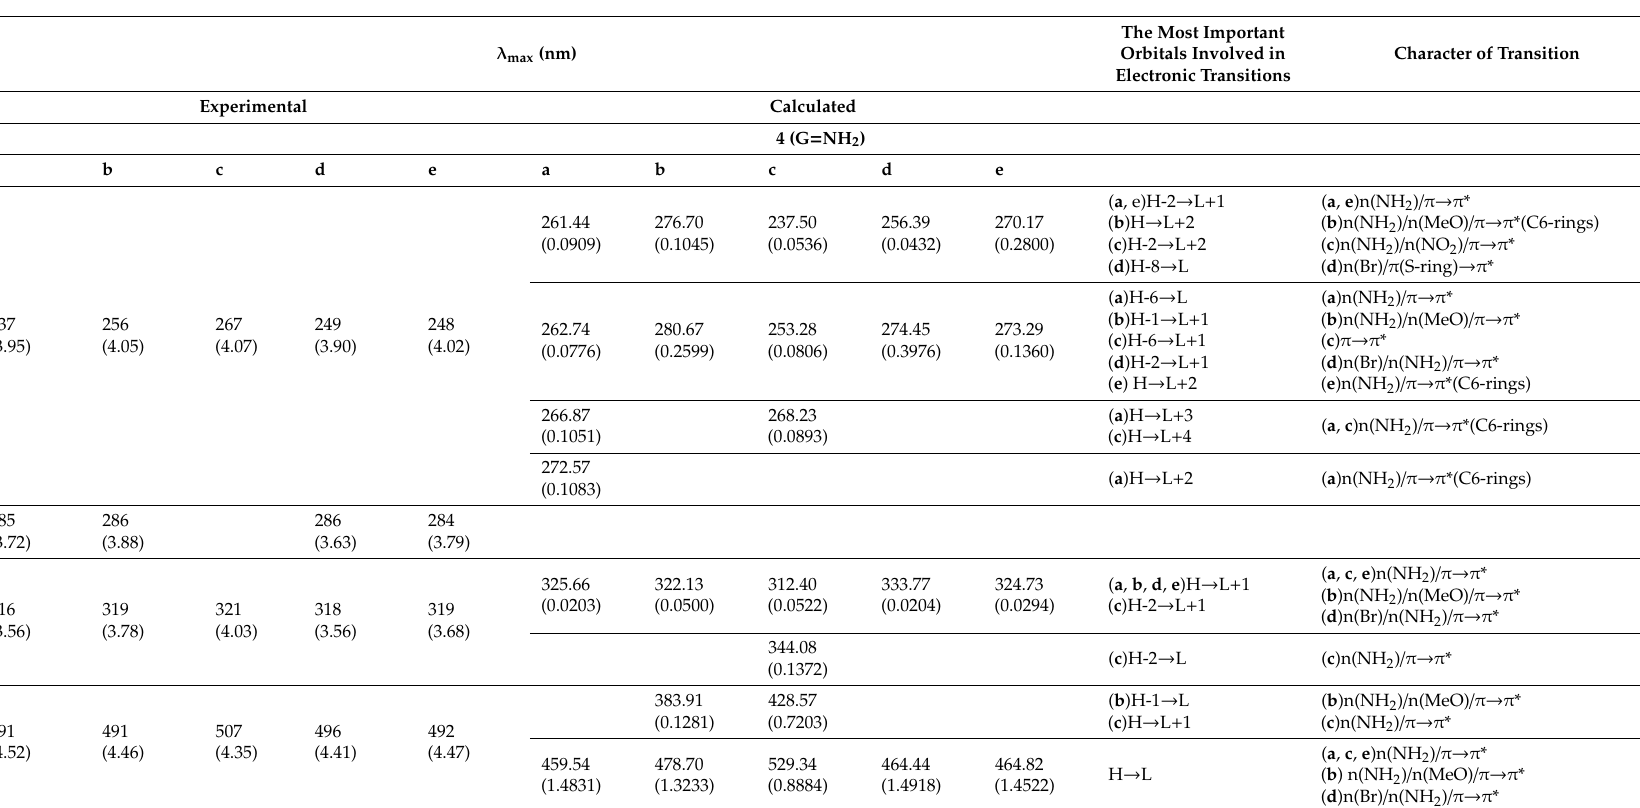
Table 1. Most important electronic transitions. H letter indicates Highest Occupied Molecular Orbital HOMO, L indicates Lowest Unoccupied Molecular Orbital LUMO and +/ − (number) represent subsequent orbitals above HOMO and LUMO, respectively. The logarithm of molar absorption coe ffi cients log ε and oscillator strengths are given in parenthesis under the wavelengths, respectively for experimental and calculated maxima. The letters a – e stand for the particular compound in a given series ( 4 , 5 or 6